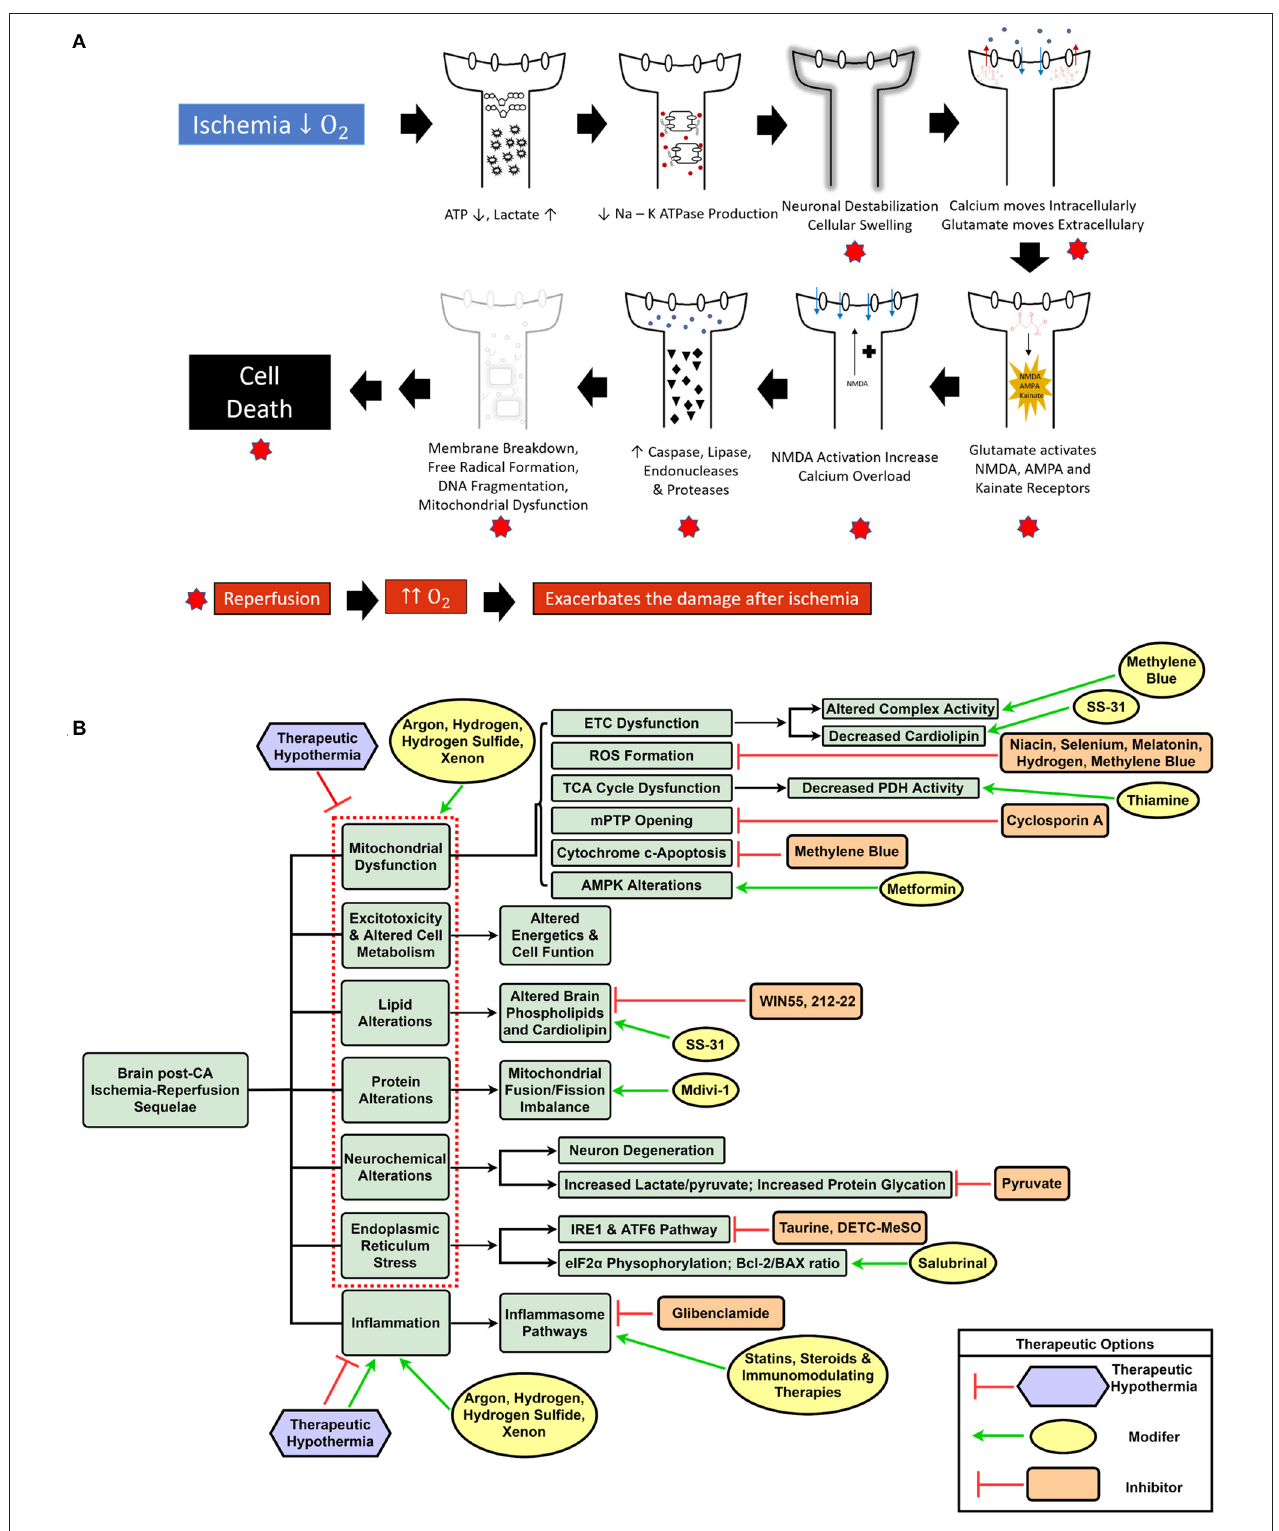
FIGURE 1 | Schematic representation of ischemia-reperfusion injury after cardiac arrest and resuscitation resulting in brain injury (A) . Overview of dysregulated pathways after cardiac arrest with a selection of inhibitory and modulatory interventions that can be combined in a cocktail therapy to confer neuroprotection (B) .